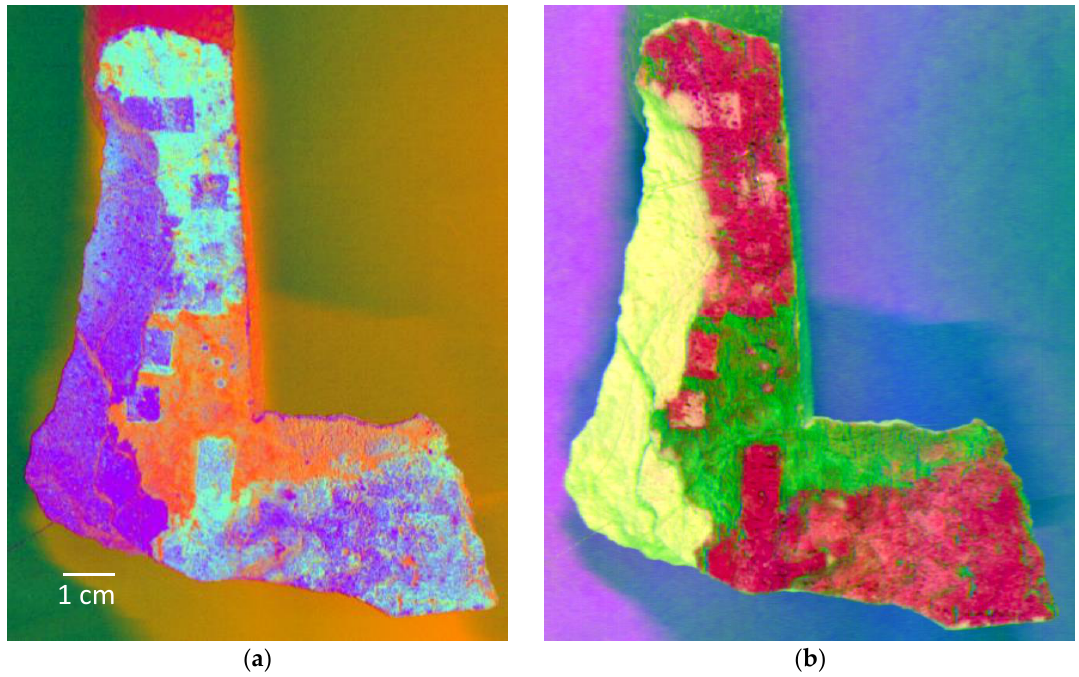
Figure 6. False color RGB maps in the Vis spectral range (420–885 nm) ( a ) and in the NIR spectral range (1300–1615 nm) ( b ).